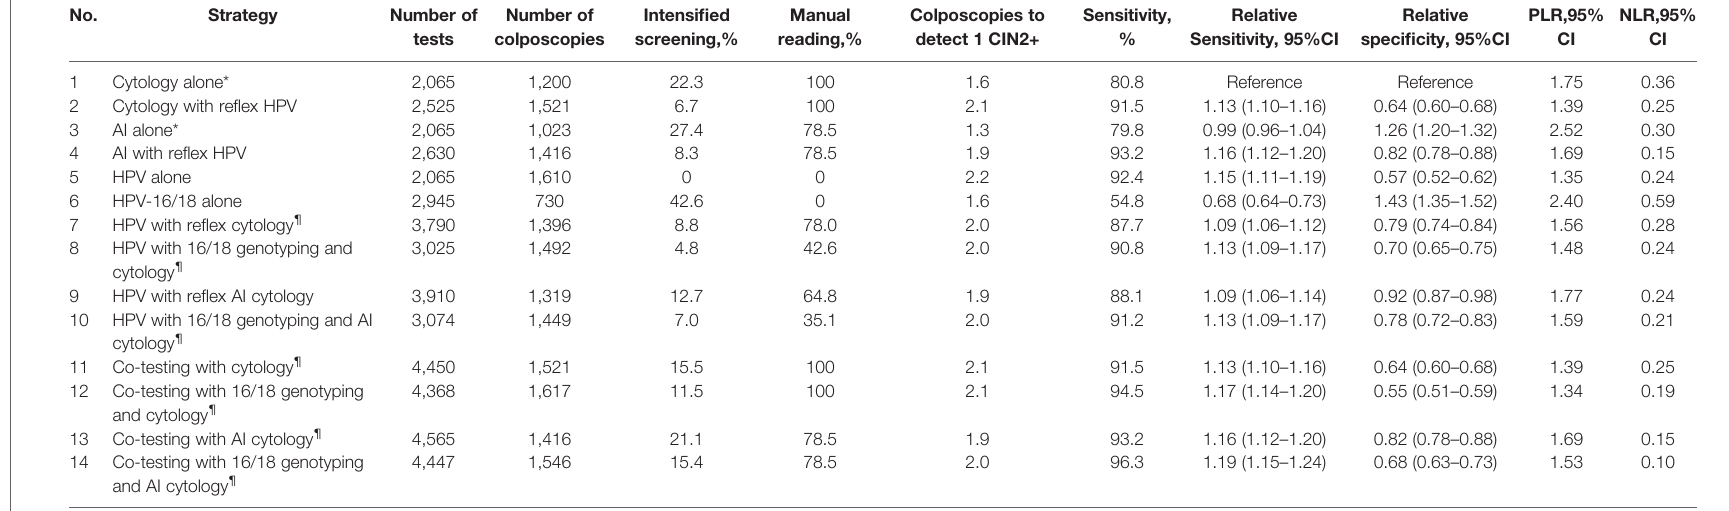
TABLE 2 | Clinical performance of different screening strategies for the detection of